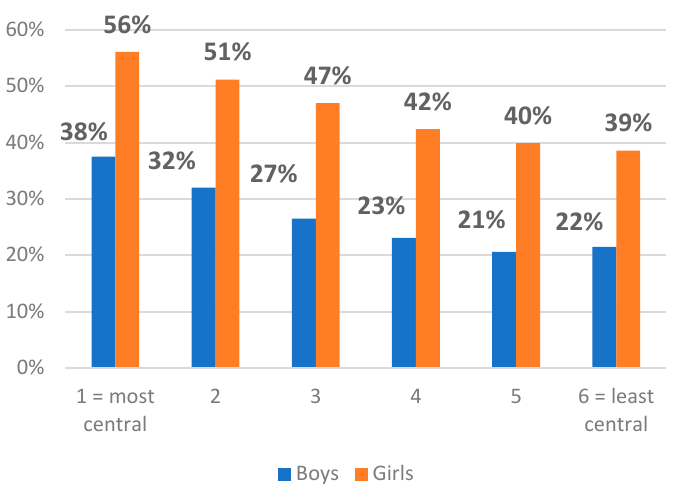
Figure 1. Prevalence of worries about climate change by gender.